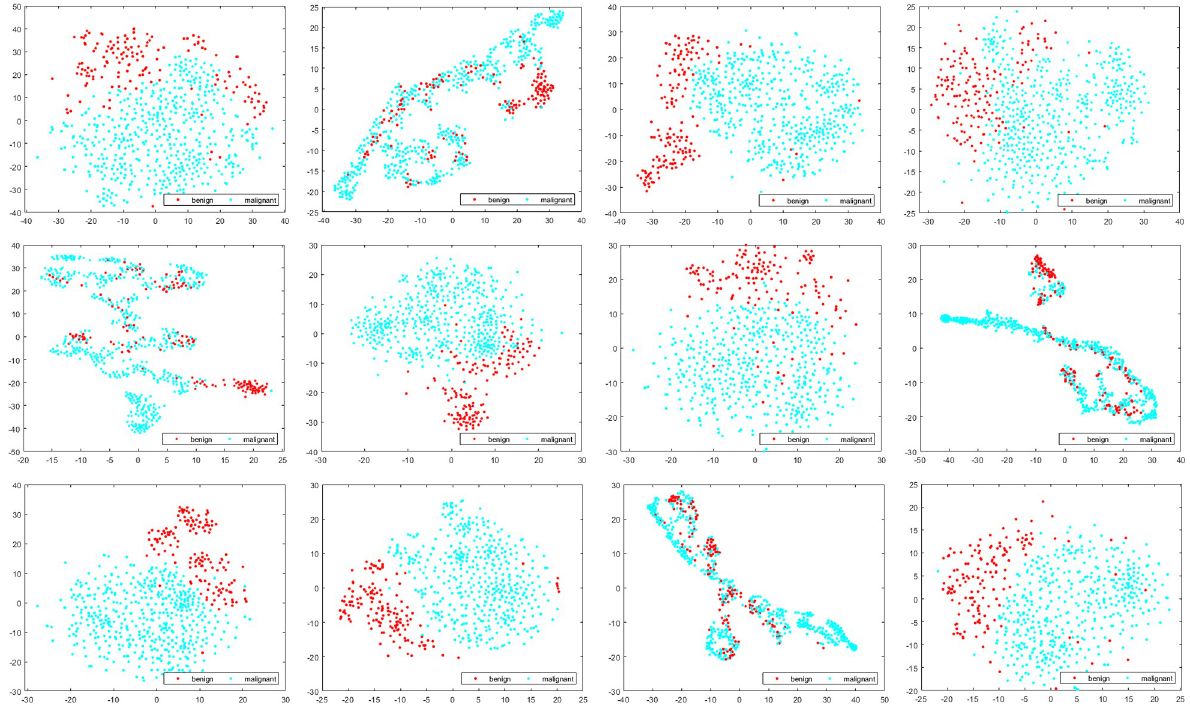
Fig 6. Visualization of different features for MSB